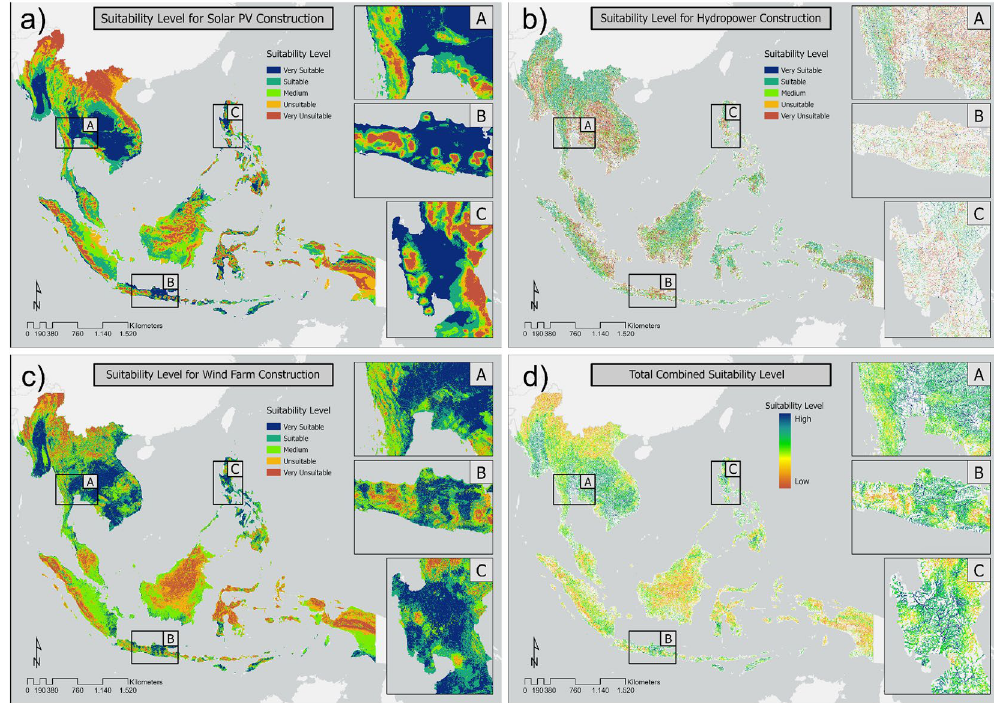
Figure 2. Levels of suitability for developing ( a ) solar photovoltaic (PV) energy, ( b ) hydropower, and ( c ) wind power infrastructure in Southeast Asia, and ( d ) the total combined suitability levels for all three types of